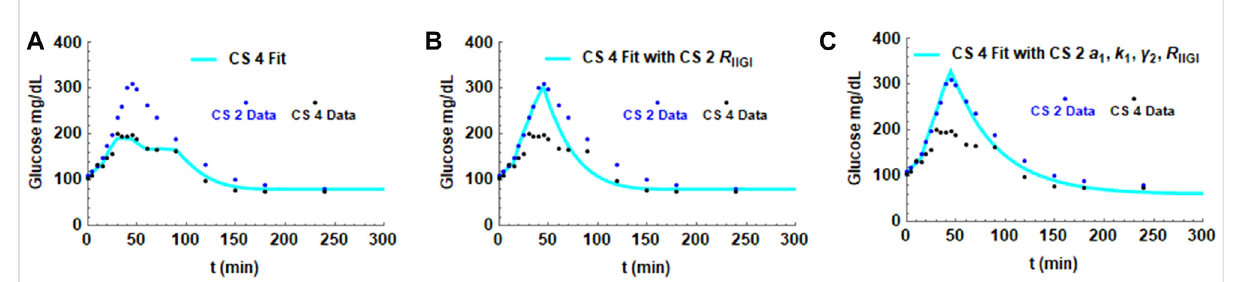
FIGURE 6 Simulations showingthe effect oftheexogenous glucose arrivalR IIGI onthe glucose pro fi le.Parameters inthe fi tfor CS 4weresubstituted with thevaluesobtained fromtheCS2 fi t.Panel (A) showsthe fi twithallCS4parameters.Panel (B) showstheeffectofsubstituting CS2glucose infusion, R IIGI, inthesimulation.Panel (C) showstheimpactofsubstitutingCS2insulinsensitivityparametera 1 ,glucagonsecretionparameter k 1 andglucagon secretion parameter γ 2 in addition to R IIGI on the CS 4 fi t.